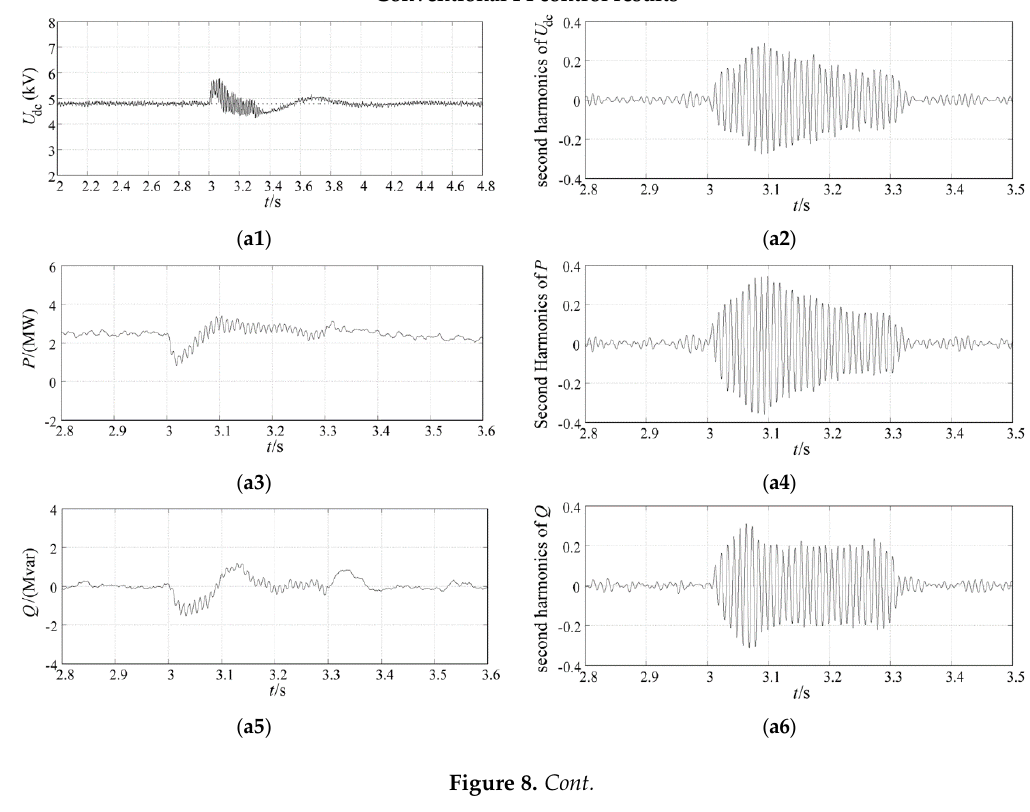
Figure 8. Cont. Figure 8.